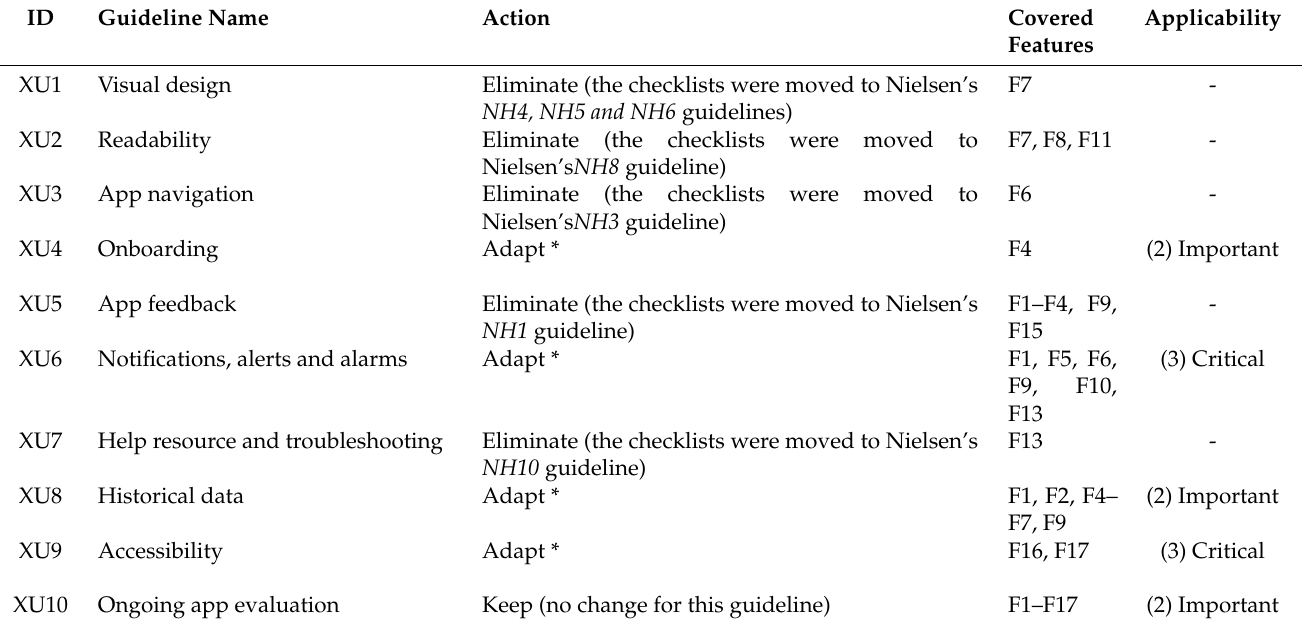
Table 5. Guideline selection process (Xcertia)